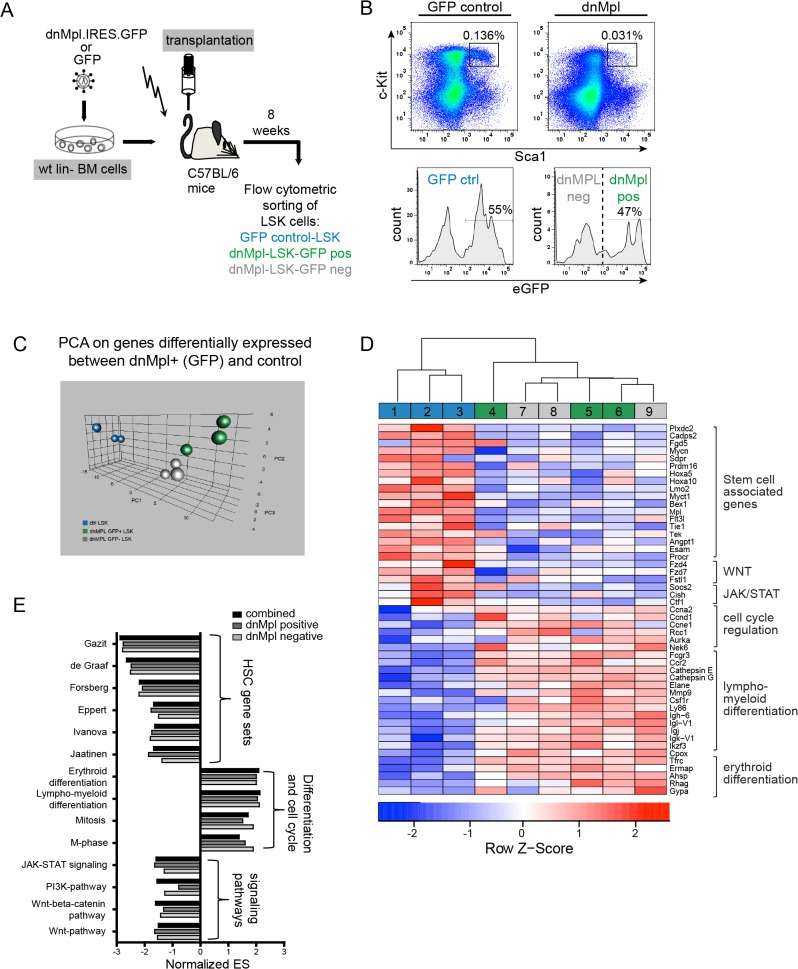
Gene expression analysis of LSK cells from dnMpl mice.(A) Schematic picture of the performed experiment. Wildtype Lin- BM cells were transduced with either GFP or dnMpl.IRES.GFP expressing vectors and transplanted into lethally irradiated wt recipients. Eight weeks after transplantation LSK cells were sorted using flow cytometry. (B) Representative FACS blots of the BM cells of GFP control and dnMpl.IRES.GFP transplanted mice. In control mice GFP positive and negative LSK cells were pooled, whereas for dnMpl.IRES.GFP mice GFP positive (47%) and negative (53%) LSK cells were separately subjected to transcriptome analysis. (C) Principal component analysis (PCA) on genes differentially expressed between dnMpl-GFP+ and control LSK cells. (D) Heatmap of selected genes found to be deregulated in the gene expression analysis. dnMpl positive and negative LSK cells from the same mice (dnMpl pos (4–6) and neg (7–9)) were compared to the expression in LSK of GFP control transplanted mice (control 1–3). (blue: donwregulated genes, red: upregulated genes). (E) Gene set enrichment analysis (GSEA) of dnMpl versus GFP control transplanted mice. The expression matrix of dnMpl positive and dnMpl negative cells from the same mice were either used in combination or separately for the GSEA. The normalized enrichment scores (NES) of gene sets are displayed that are significantly enriched in the dnMpl phenotype. Most of the gene sets were part of the gene set collection of the GSEA tool and depicted based on the following publications [13,15,34,35,46,47,54] or based on the KEGG database.